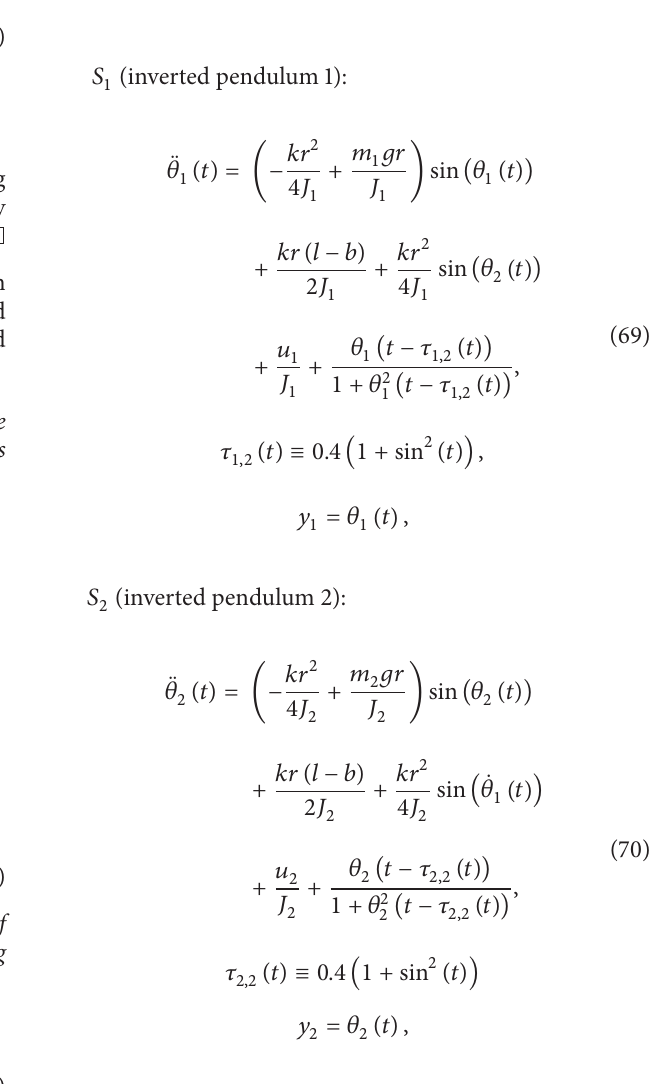
Figure 1: The two-inverted-pendulum system coupled by a